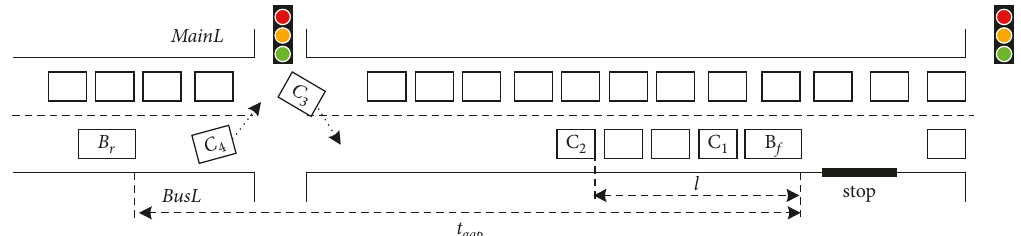
Figure 1: Typical road section for calculating the capability of